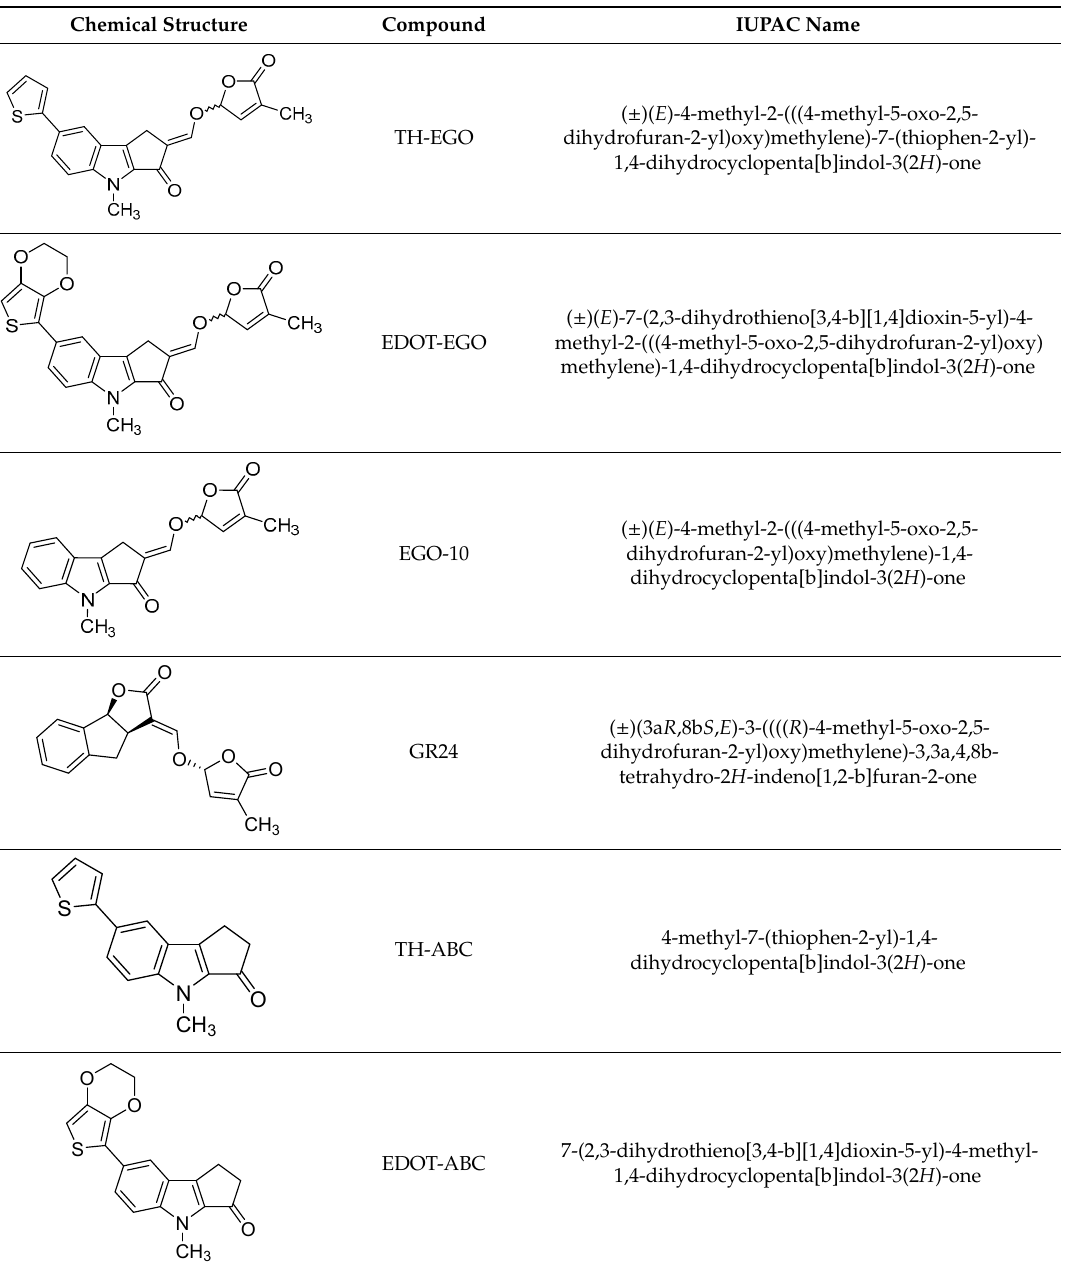
Table 1. Strigolactone (SL) compounds used in this study.